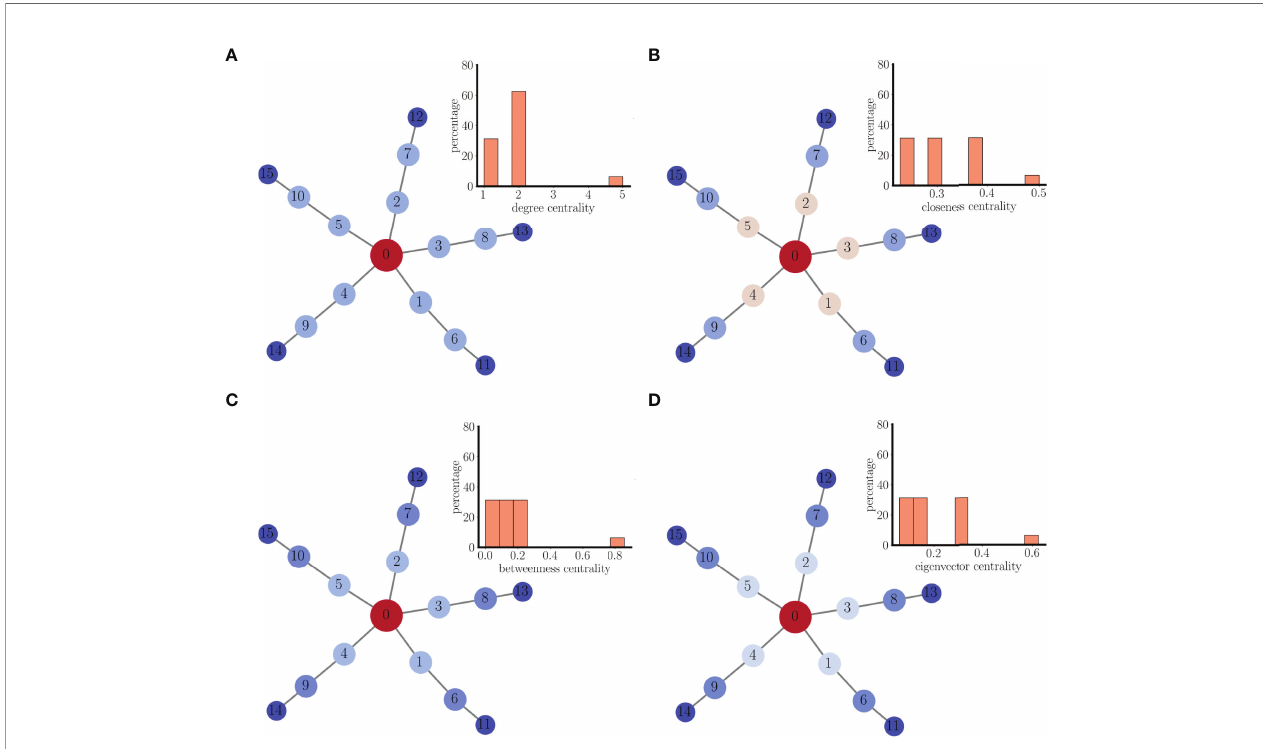
FIGURE 6 | A multi-arm structual network of coupled pseudo-plateau bursters. (A) Nodes are colored according to degree centrality. The inset is a histogram of the centrality for all nodes in the network. (B) Nodes are colored according to closeness centrality. (C) Nodes are colored according to betweenness centrality. (D) Nodes are colored according to eigenvector